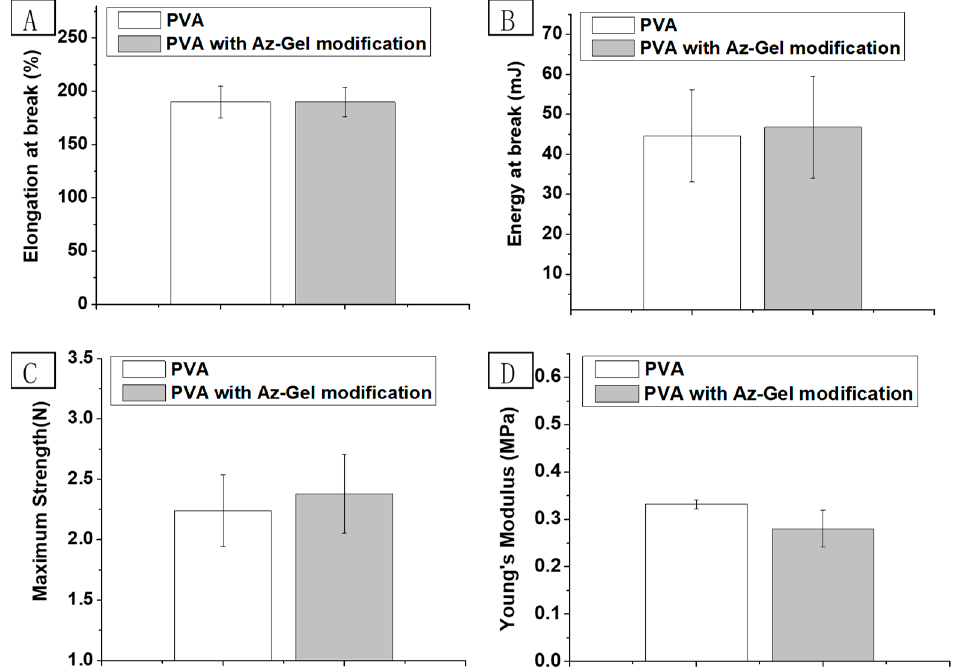
Figure 2. Elongation ( A ), energy at break ( B ) maximum strength ( C ) and young’s modulus ( D ) of PVA and Az-Gel@PVA dressings. Error bars represent standard deviation for n = 3.